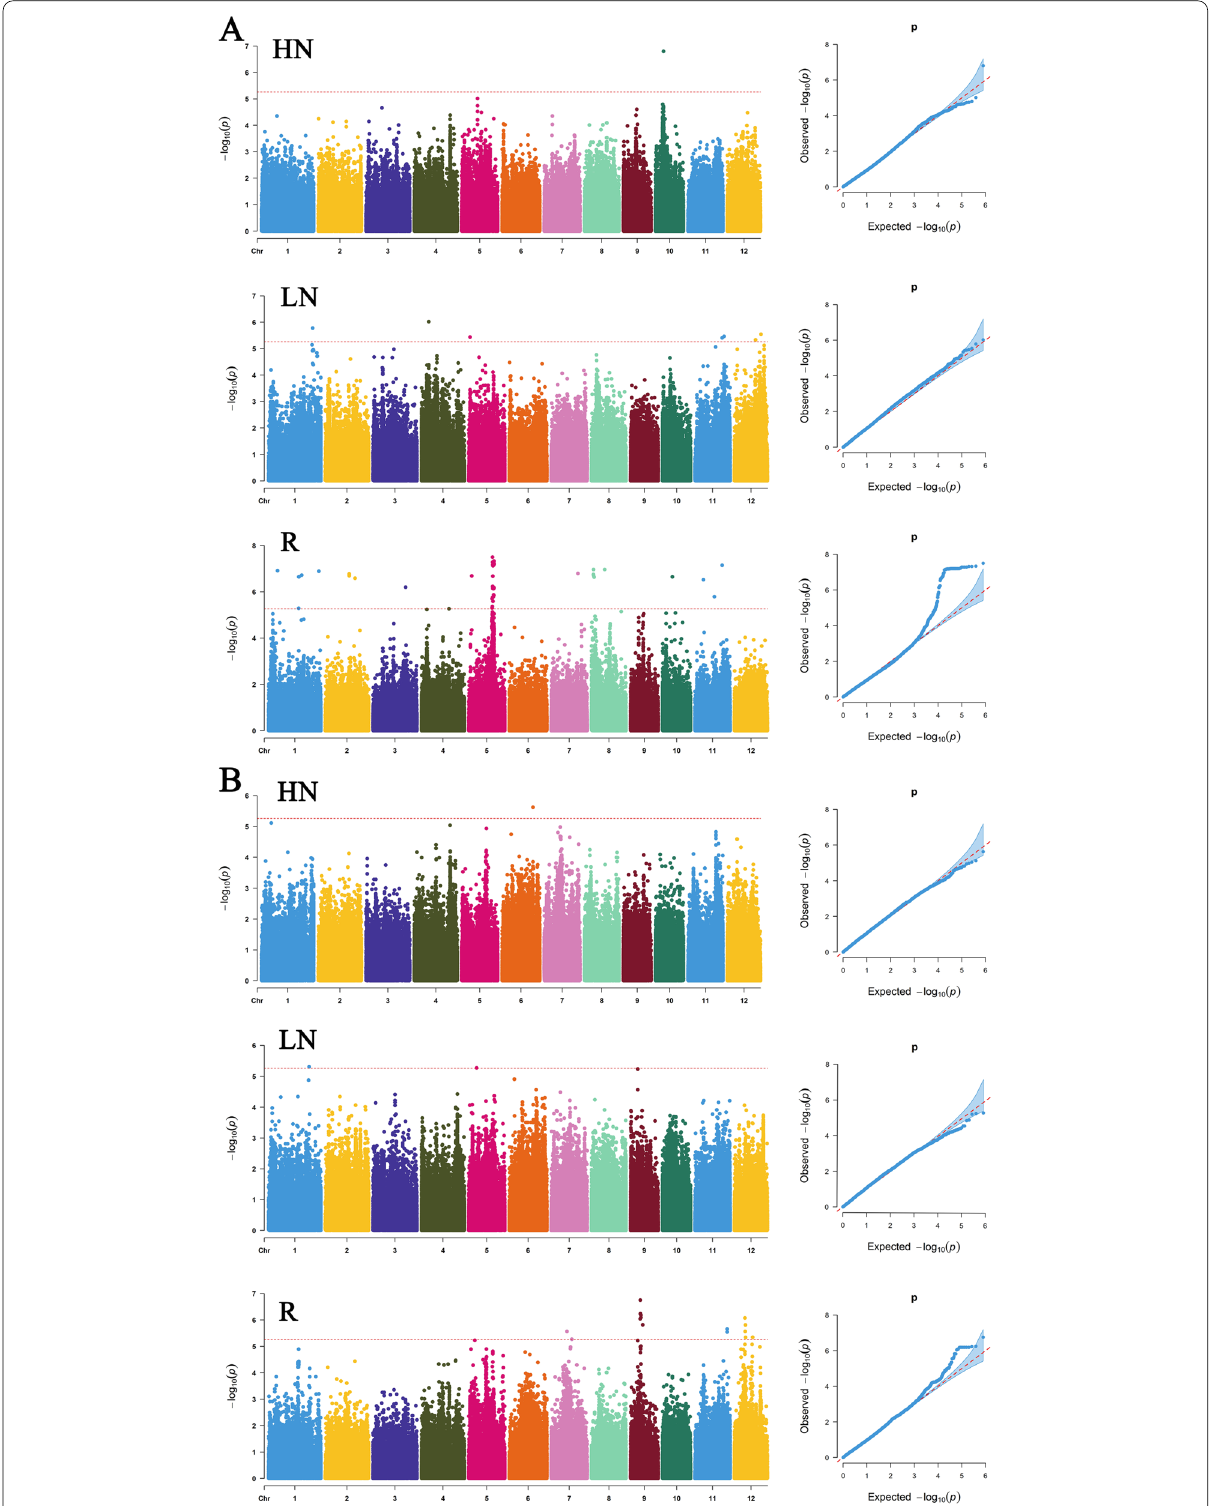
Fig. 2 Manhattan plots and quantile–quantile (Q–Q) plots of root morphology traits. A GWAS assays of root diameter under high and low nitrogen treatments. B GWAS assays of root length under high and low nitrogen treatments. LN: low-nitrogen. HN: high-nitrogen. R: relative value of traits under low and high nitrogen